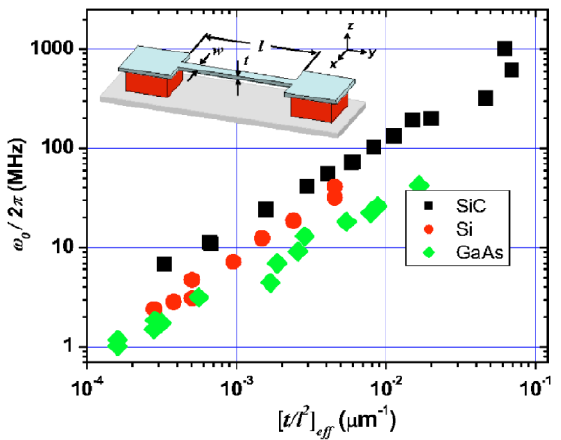
Figure 10. Relationship between the resonant frequency and effective geometry of the doubly clamped beam resonators made from single-crystal SiC, Si, and GaAs. Reused with permission from